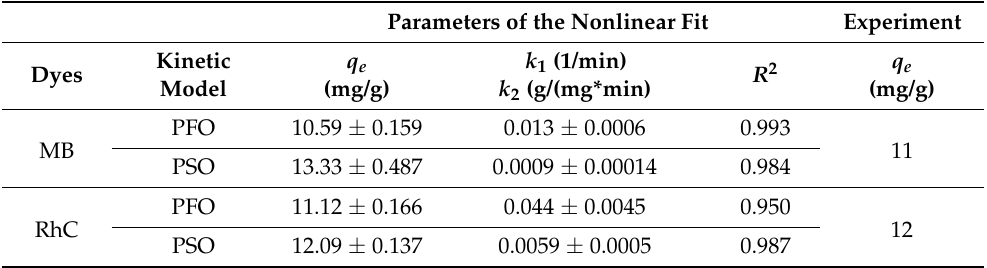
Figure 10. ( a ) q t dependence on the Fe 3 O 4 @C contact time with MB and RhC; solid line is fitting to the pseudo-first-order (PFO) and dotted line to pseudo-second-order (PSO) models. ( b ) Presentation of kinetic data in coordinates q t from t 1/2 .